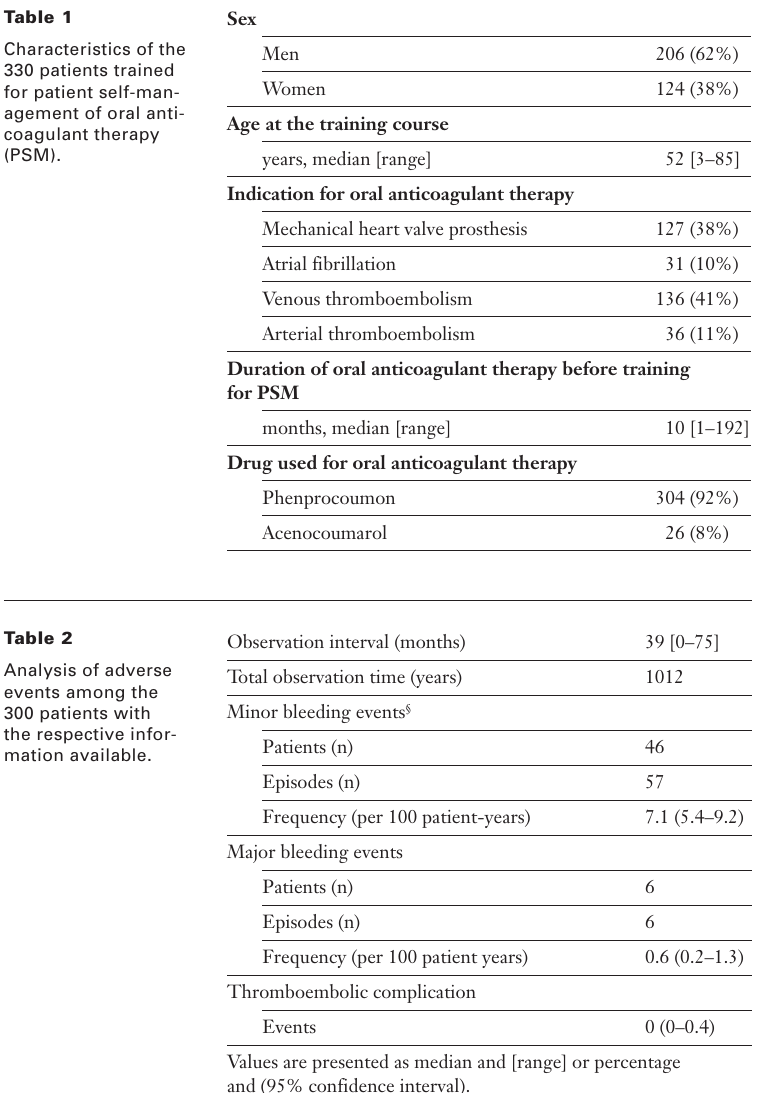
Flow of the 330 pa- tients who had been trained for patient self-management (PSM) of OAC be- tween 1998 and